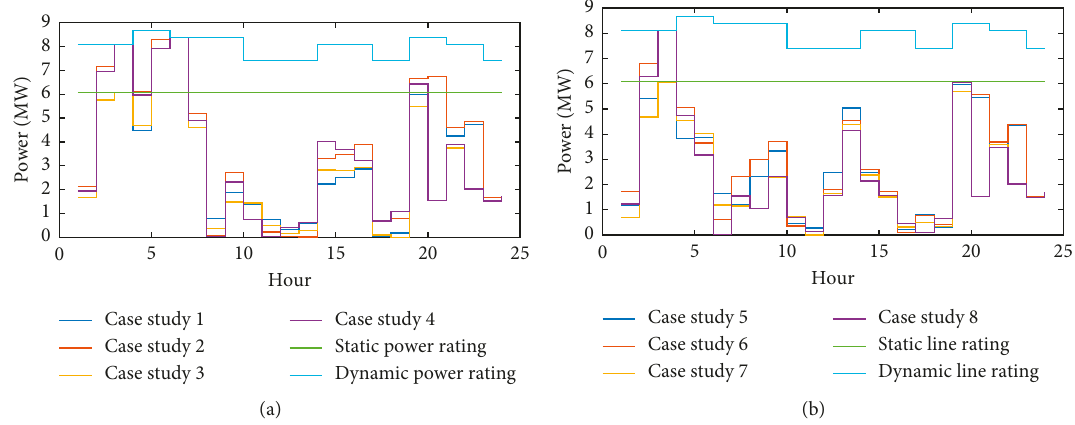
Figure 20: A-B conductor power flow for case studies, static line rating, and dynamic line rating: (a) case studies 1, 2, 3, and 4; (b) case studies 5, 6, 7, and 8.